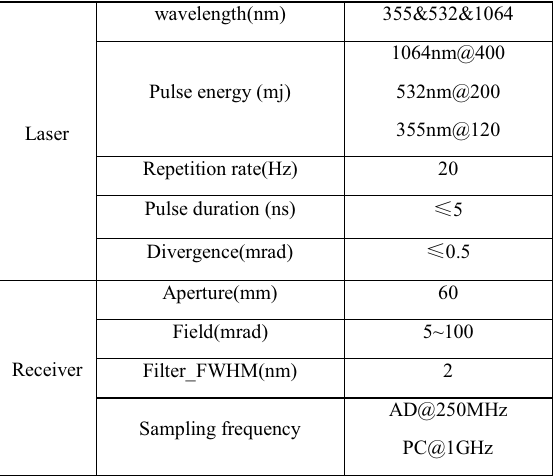
Table 1. LOOP system hardware configuration.